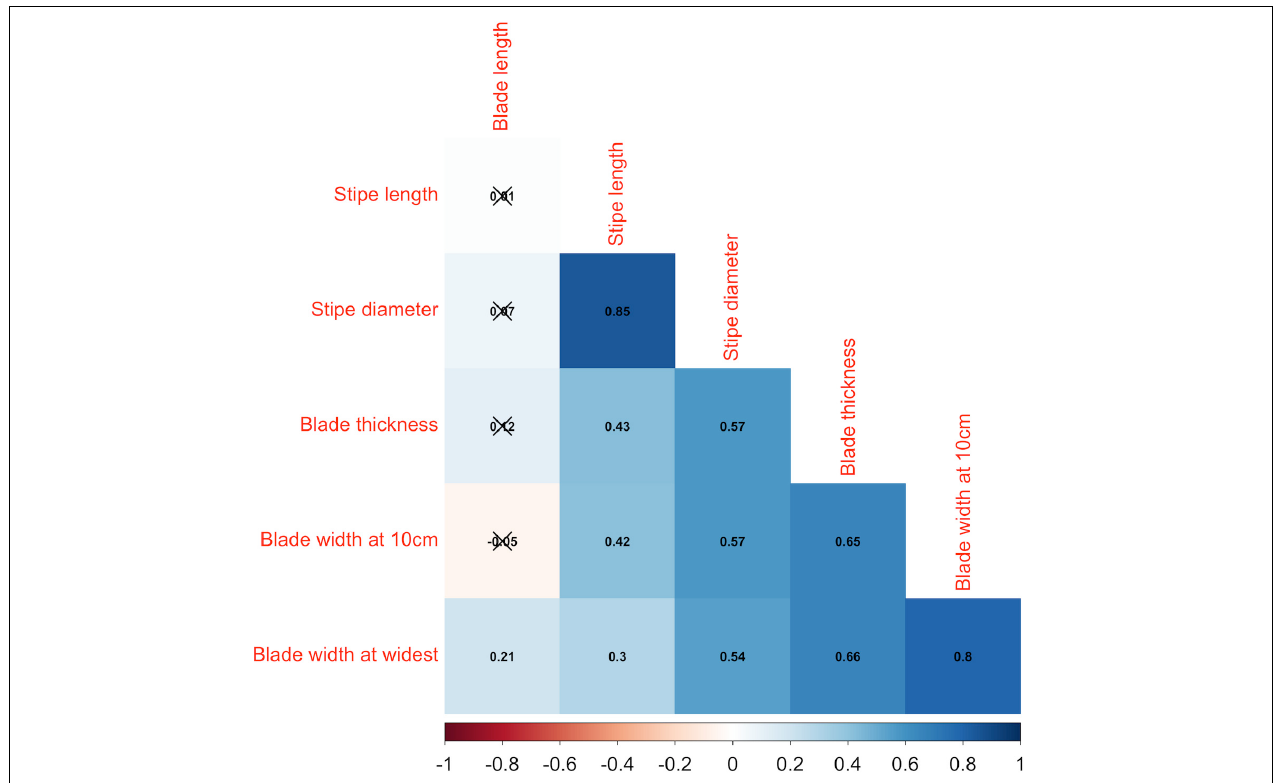
FIGURE 2 | Phenotypic correlations among six morphological traits. The color gradient is shown at the bottom with red representing a negative correlation and blue representing a positive correlation. Non-significant ( P > 0.05) correlations were marked with black